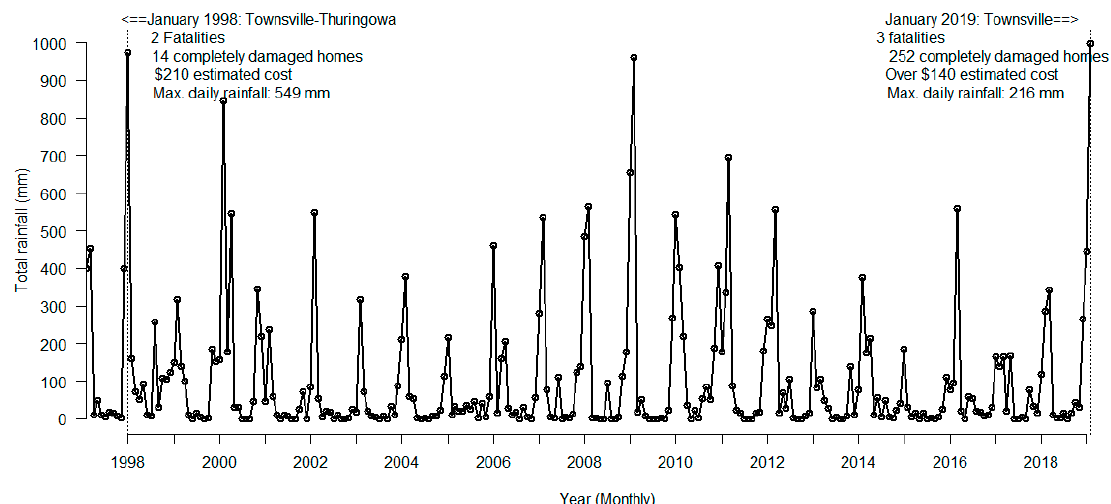
Figure 1. Total monthly rainfall in Townsville area. The dotted line indicates flooding events.